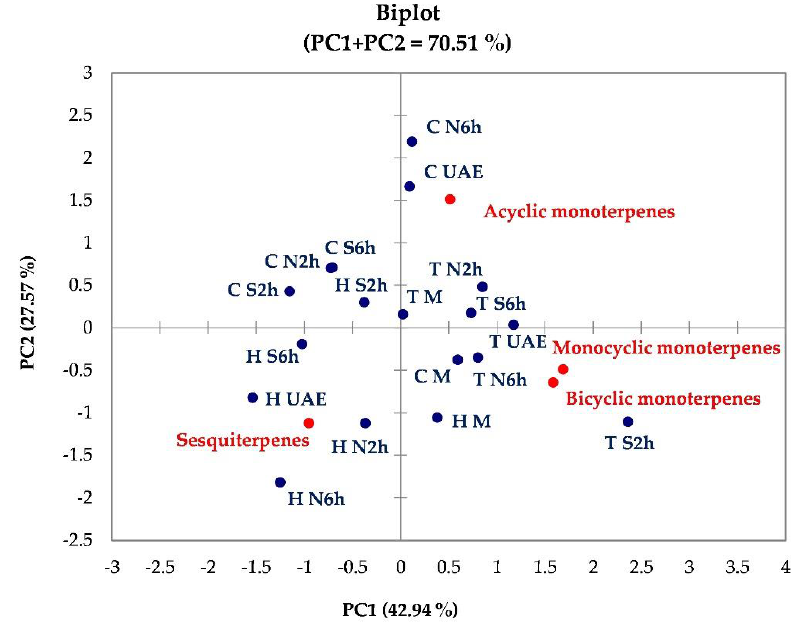
Figure 1. Biplot (scores and loadings) obtained from the PCA on data set of different extracts (rows) and terpenes classes analyzed (columns). In the Figure: T, thyme; H, hemp; C, coriander seeds; N2h, RSLDE 2 h; N6h, RSLDE 6 h; S2h, Soxhlet 2 h; S6h, Soxhlet 6 h; UAE, ultrasound assisted extraction; M, maceration.